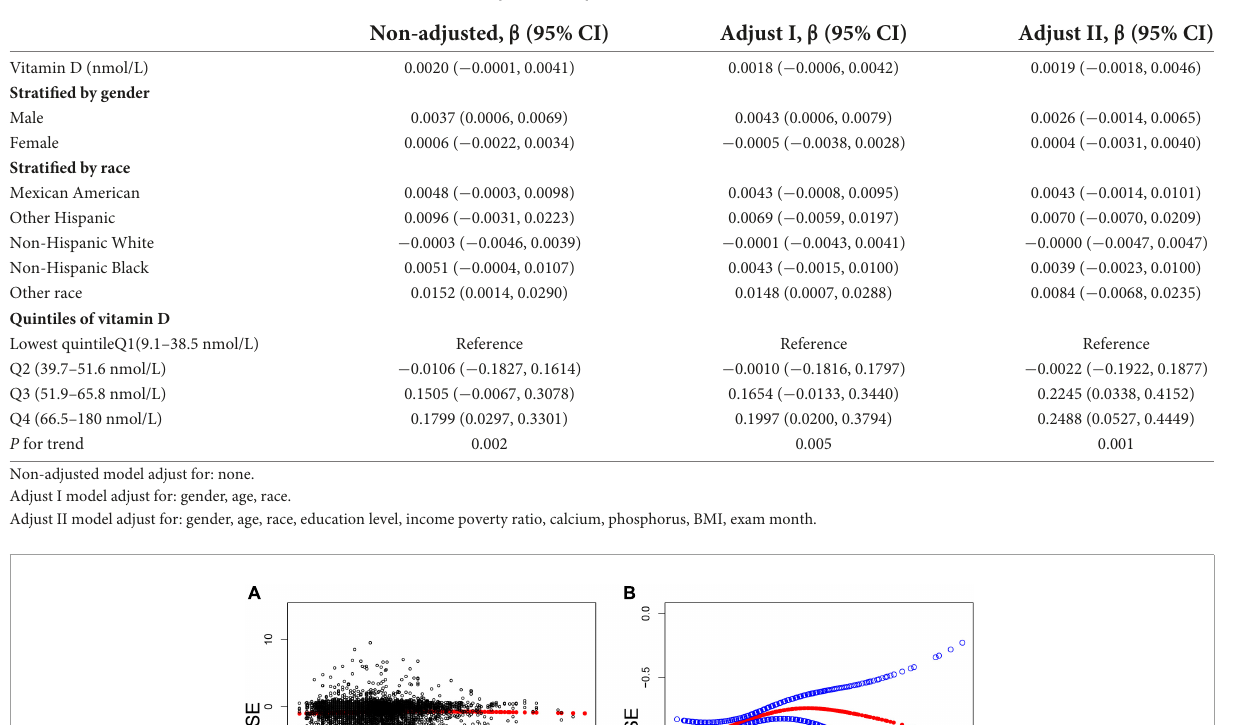
TABLE 2 The association between Vitamin D (nmol/L) and spherical equivalent (D).